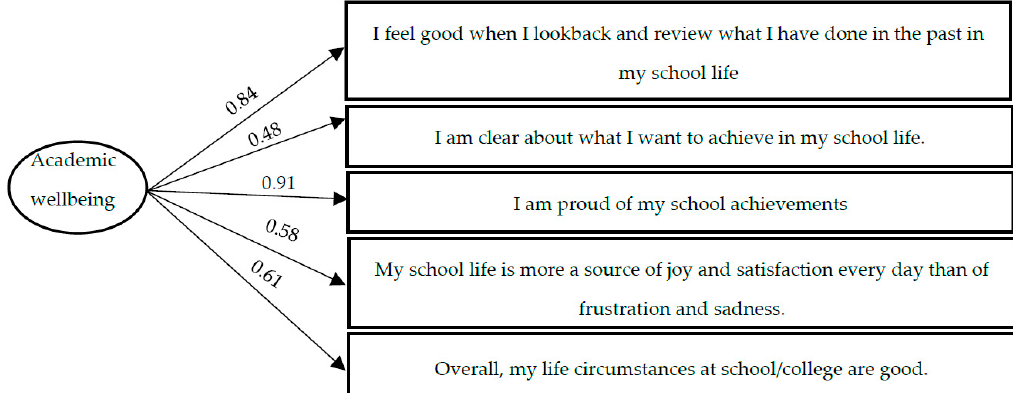
Figure 2. Measurement model of the Subjective Academic Wellbeing scale.